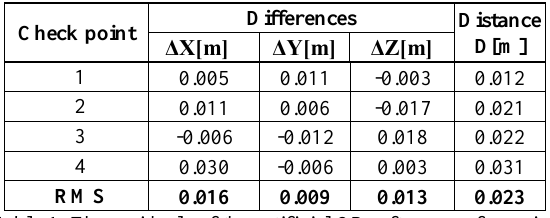
Differences Distance